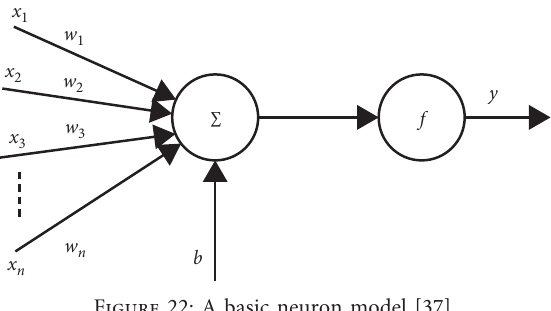
Figure 22: A basic neuron model [37].